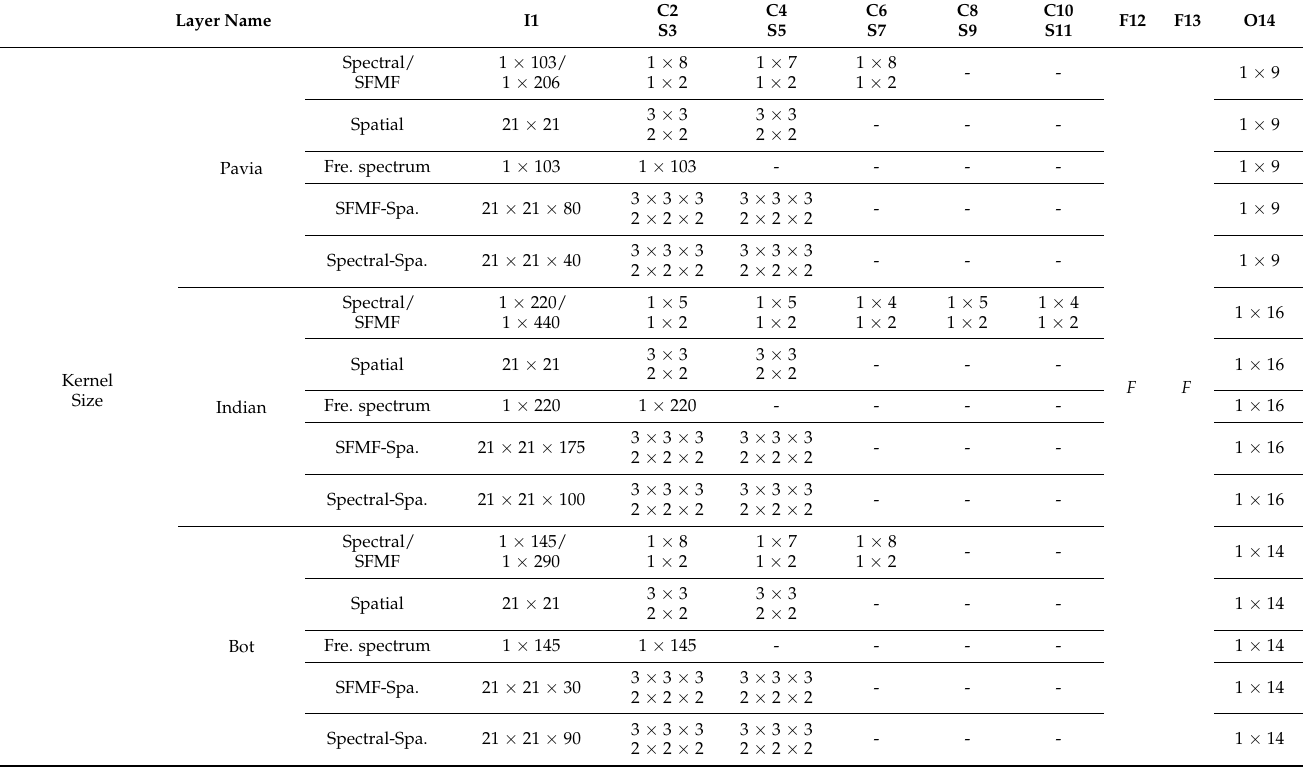
Table 1. Architecture of basic CNN and 3-D CNN on each